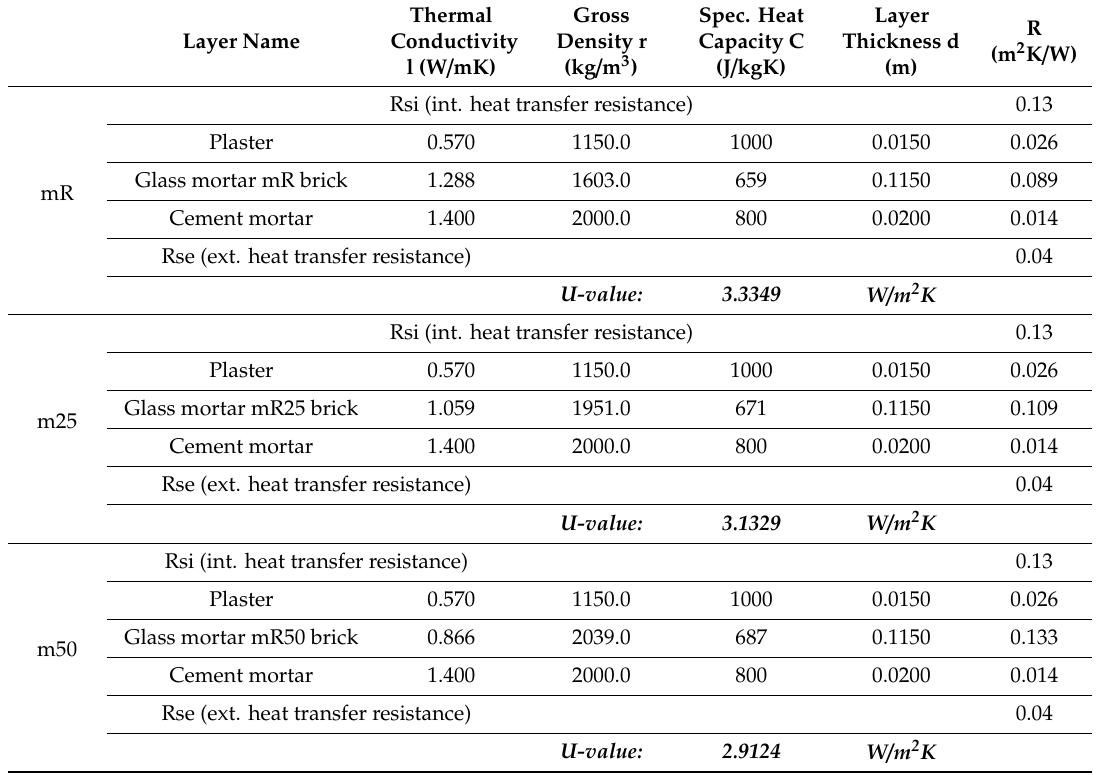
Table 2. 15 cm brick thermal transmittance: mR, m25, m50.